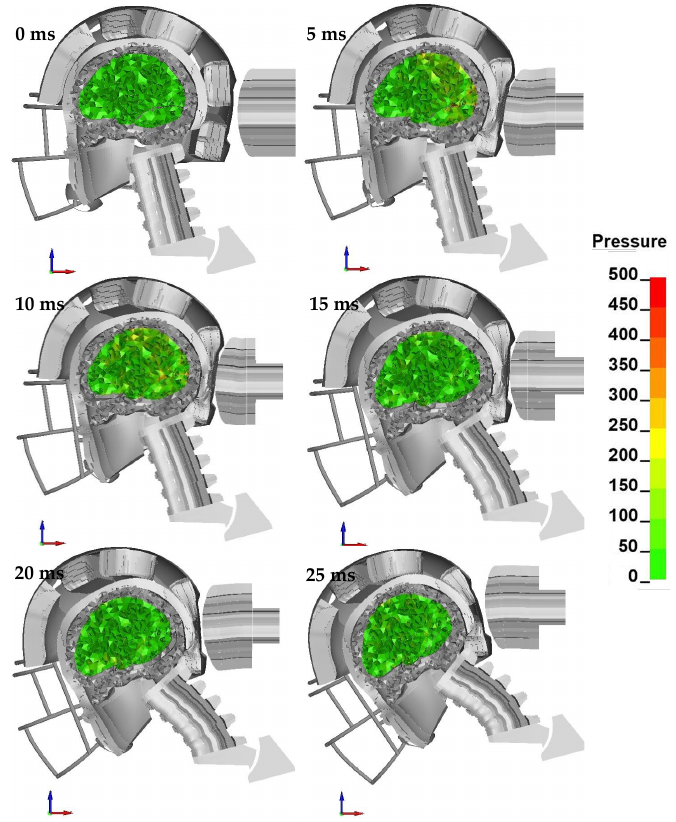
Figure A18. Head kinematics during the numerical test, configuration R, with the cross-section in the median plane and showing the hydrostatic pressure (kPa) in the cerebrum.